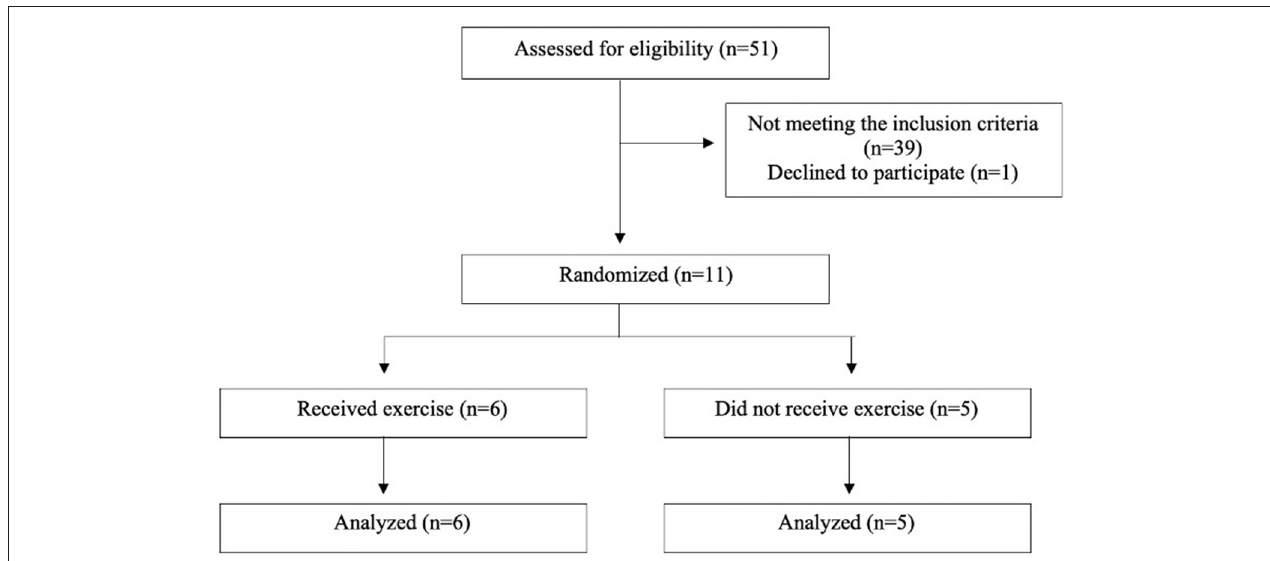
FIGURE 1 | Flow chart of the study